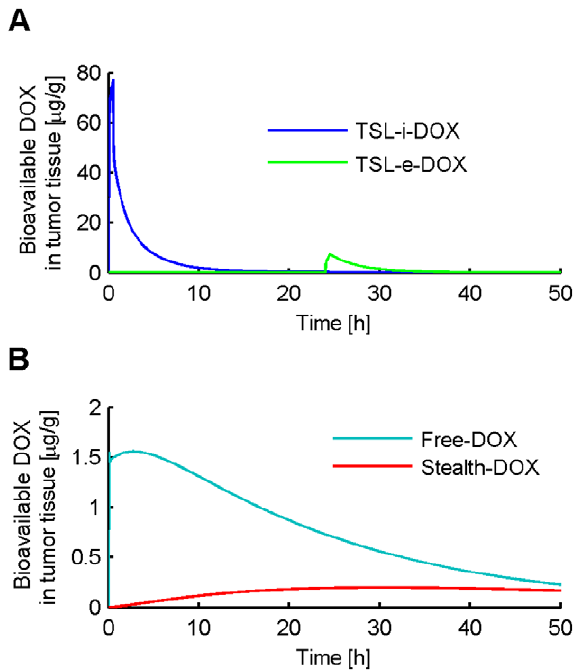
Figure 5. Bioavailable tumor tissue DOX concentration for (A) TSL-i-DOX and TSL-e-DOX , and (B) Free-DOX and Stealth-DOX over time.